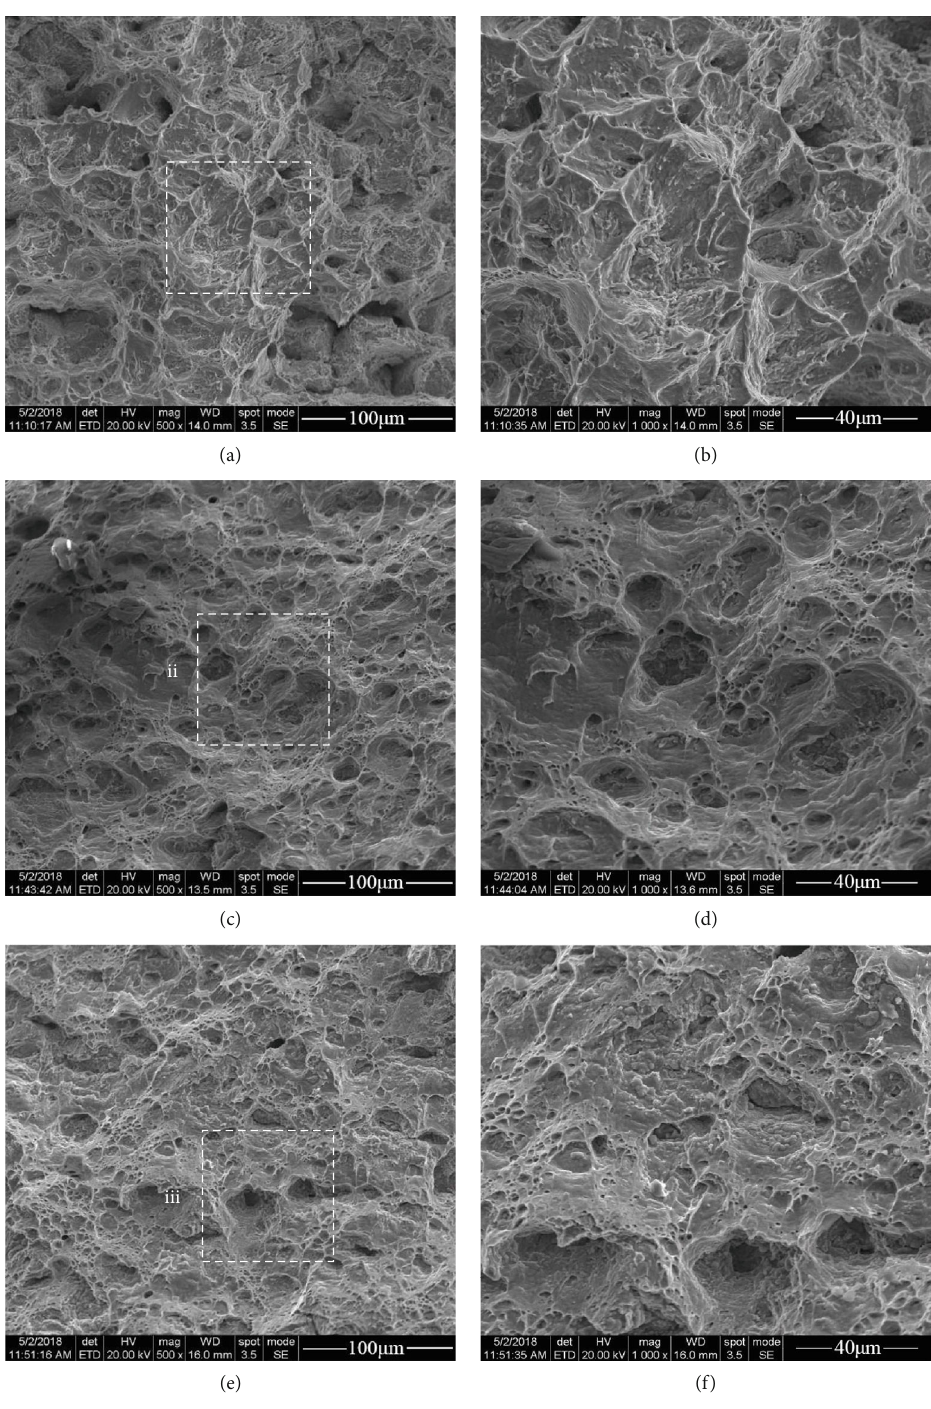
Figure 10: SEM fracture micrographs of the aluminized steel with di ff erent impact times of LSP under the stress of 210 MPa: (a) aluminized steel; (b) aluminized steel with single LSP impact; (c) aluminized steel with three LSP impacts; (d) magni fi cation of area i; (e) magni fi cation of area ii; and (f) magni fi cation of area